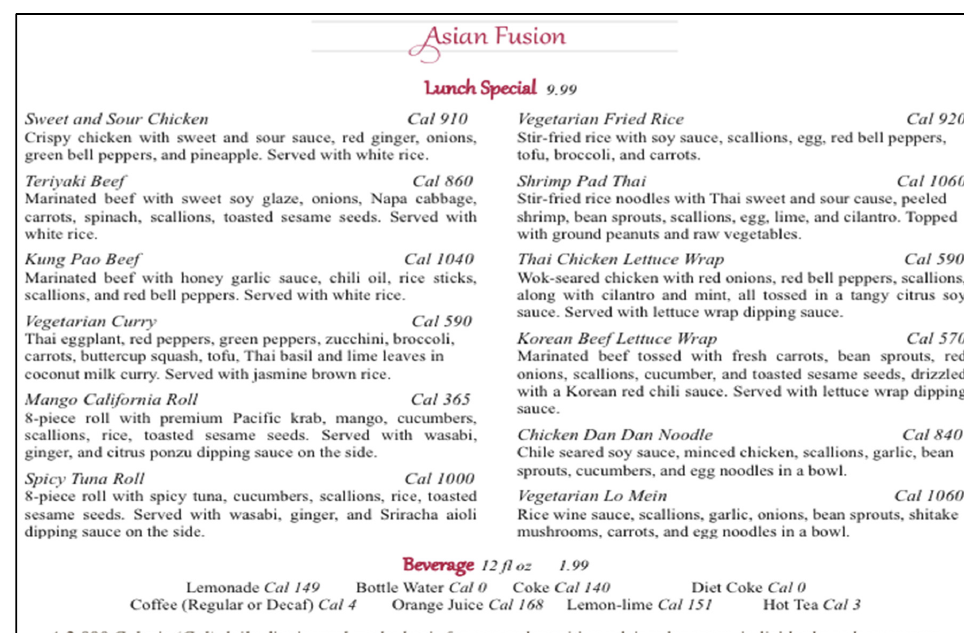
Nutrients 2021 , 13 , x FOR PEER REVIEW